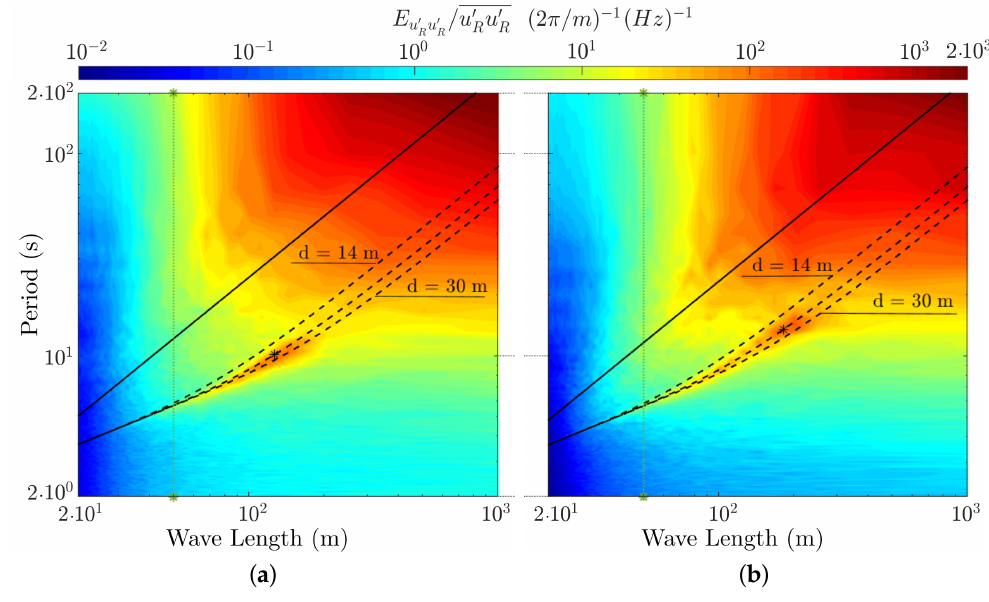
( k , w ) , for ( a ) Case 01 and ( b ) Case (cid:48) R u R